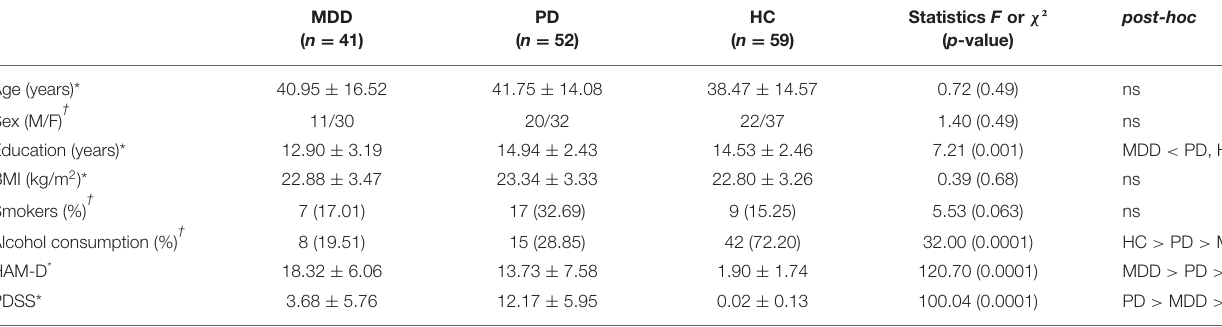
TABLE 1 | Baseline demographics and clinical features by groups ( n =